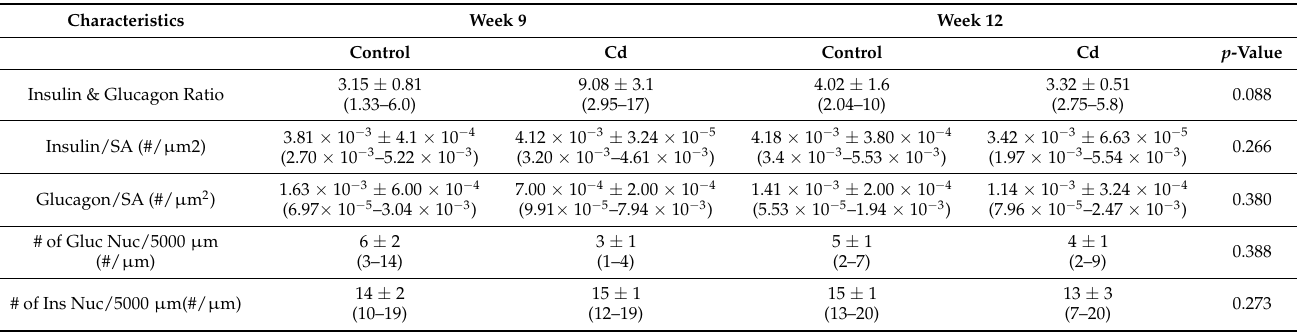
Table 3. All values are mean ± SEM; ranges are also given underneath actual values. Pancreata from a minimum of four animals from each treatment group and time point were